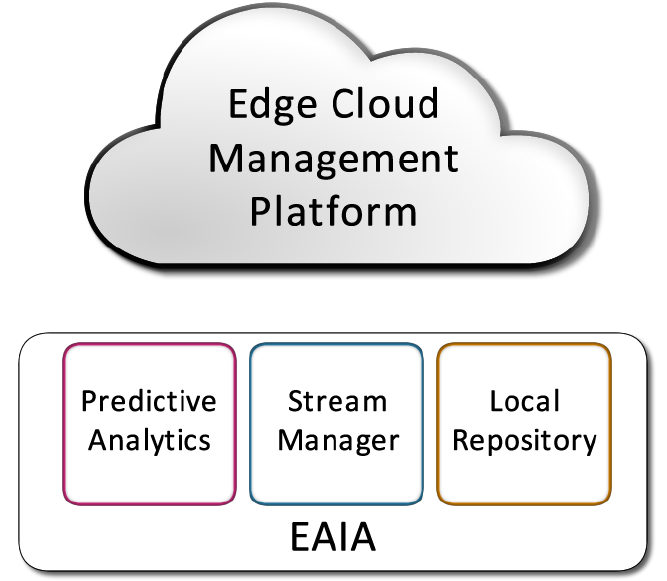
Figure 11. EAIA local